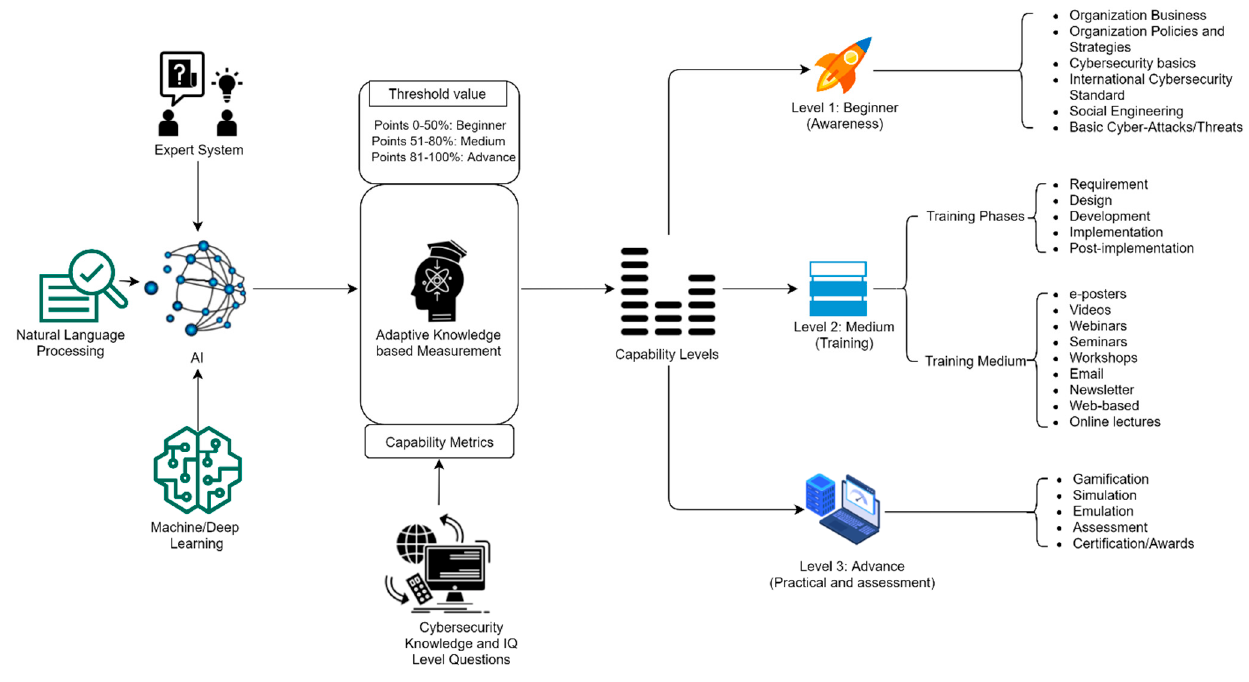
Figure 3. Entire structure of the CAT framework .